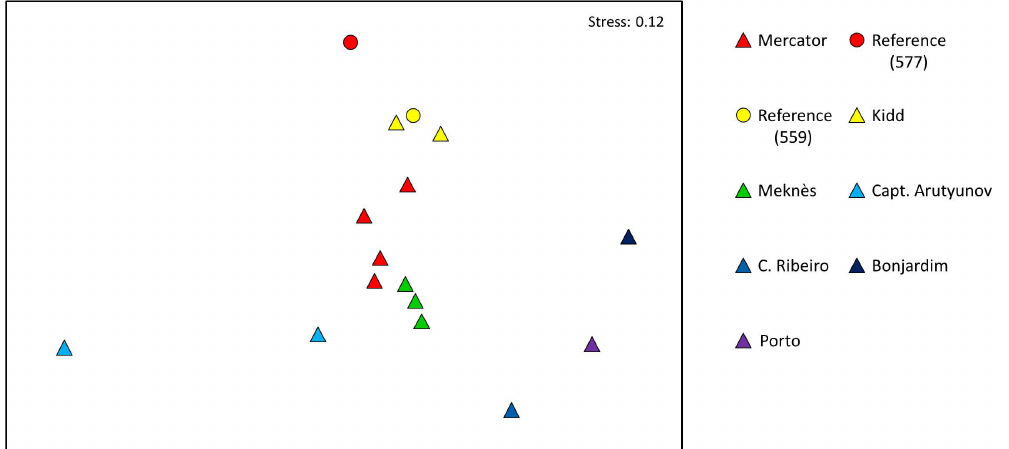
Fig. 4. MDS plots for the comparison between samples from Reference sites, Shallow MVs (Mercator, Kidd and Mekn`es) and Deep MVs (Capt. Arutyunov; Carlos Ribeiro, Bonjardim and